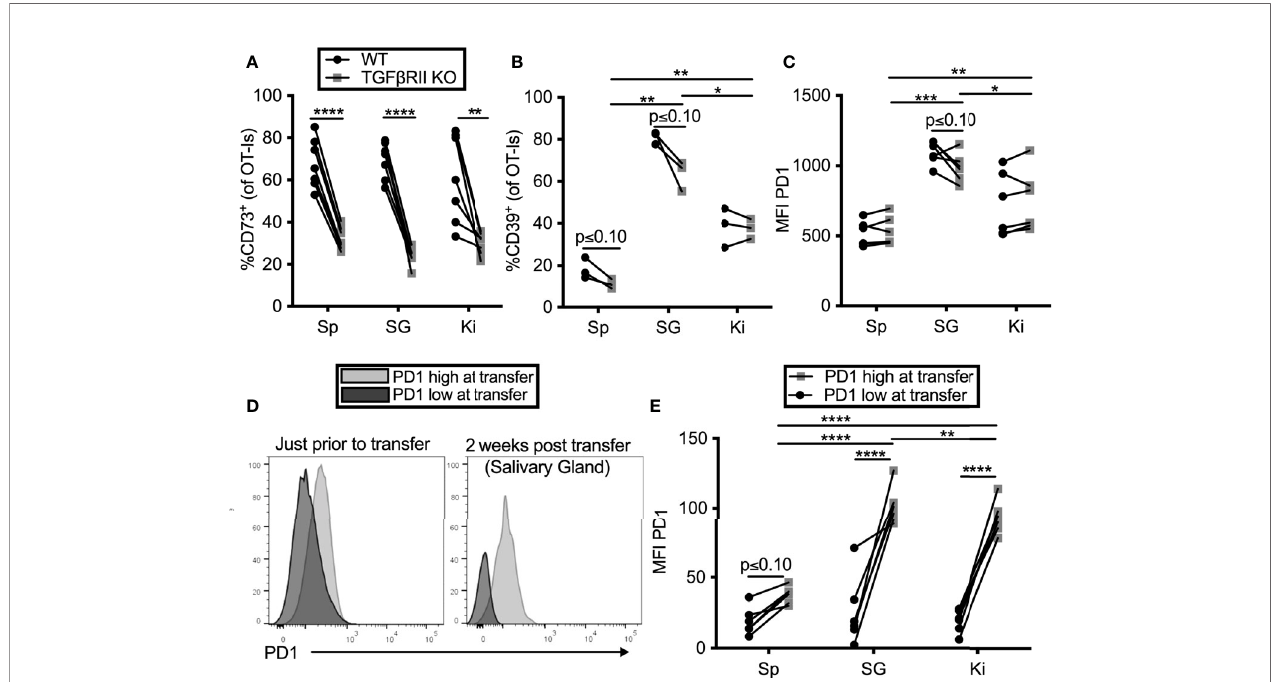
FIGURE 3 | TGF- b induces CD73 expression on CD8 + T cells, but PD-1 is sustained by tissue localization. (A – C) Mice were seeded with a mixture of wild type (WT) and TGF b II receptor KO OT-Is and infected with MCMV-OVA. Mice were sacri fi ced at least 1 month post infection. Expression of (A) CD73 (B) CD39 and (C) PD-1 on OT-Is from the indicated organs. Lines connect TGF b II receptor KO OT-Is and WT OT-Is from the same mice. Data were analyzed with paired t-tests to assess differences between WT and KO cells recovered from the indicated organ of each animal and to compare cells between organs of the same animal (n=7 mice pooled from 2 independent experiments). (D, E) PD-1 high OT-Is were generated by seeding mice with RAG -/- OT-Is, infecting recipients with MCMV-OVA and harvesting T cells on day 7. PD-1 low populations differing at the CD45 locus were generated by activating RAG -/- OT-I T cells in vitro with peptide for three days and then resting for three days without peptide stimulation. PD-1 high and PD-1 low populations were mixed and adoptively transferred into naïve mice. (D) Representative FACS plots of PD-1 expression on the in vivo (PD-1 high ) and in vitro (PD-1 low ) generated T cells just before adoptive transfer and again, on i.v. antibody-negative OT-Is after recovery from the salivary gland two weeks after adoptive transfer. (E) Mean fl uorescence intensity of PD-1 expression on OT-Is recovered from recipient mice two weeks after transfer. Lines connect the two different OT-I populations recovered from the same recipients. Data were analyzed with paired t-tests to assess differences between WT and KO cells recovered from the indicated organ of each animal and to compare cells between organs of the same animal (n=6 mice pooled from 2 independent experiments) *p ≤ 0.05, **p ≤ 0.01, ***p ≤ 0.001, ****p ≤